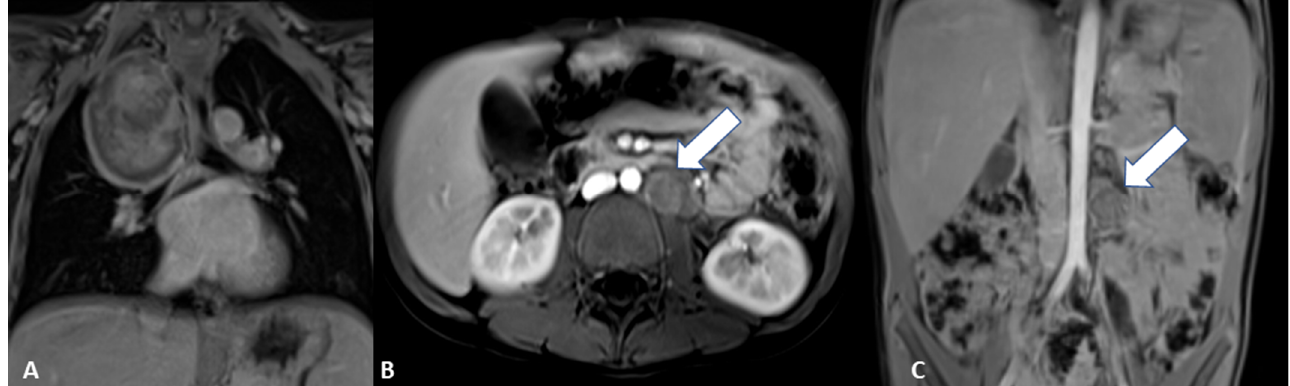
Figure 7. Reevaluation with MRI showed the thoracic lesion with unchanged features ( A ), and a residual tumor >2 cm at abdominal lesion ( B ) with a local enlarged lymph node ( C ). Clinical (L2 stage and age >18 months), histological and molecular features (MYCN not amplified and presence of SCAs) led to classification into the intermediate risk group according to the Low/Intermediate risk Neuroblastoma European Study (LINES) [2] .